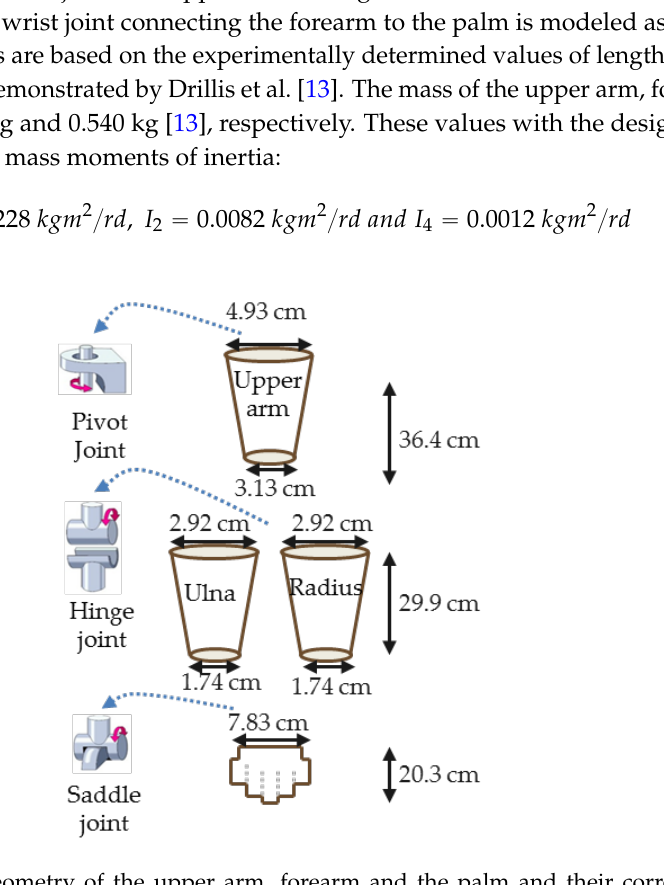
Figure 1. Modeled geometry of the upper arm, forearm and the palm and their corresponding modeled joints.